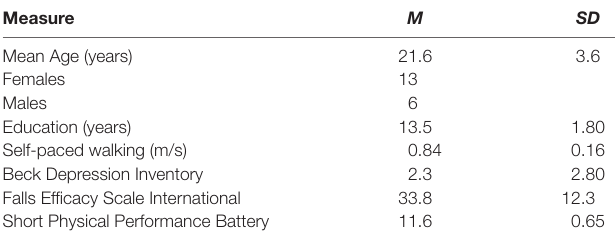
TABLE 1 | Mean ( M ) and standard deviation ( SD ) for the participant demographics and health